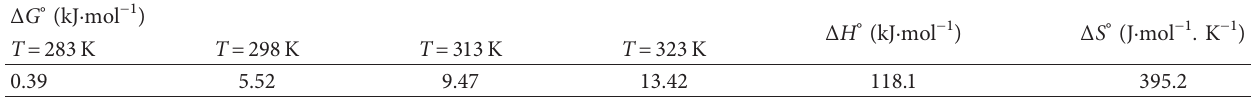
Table 3: Thermodynamic parameters of MB adsorption onto the sediment.